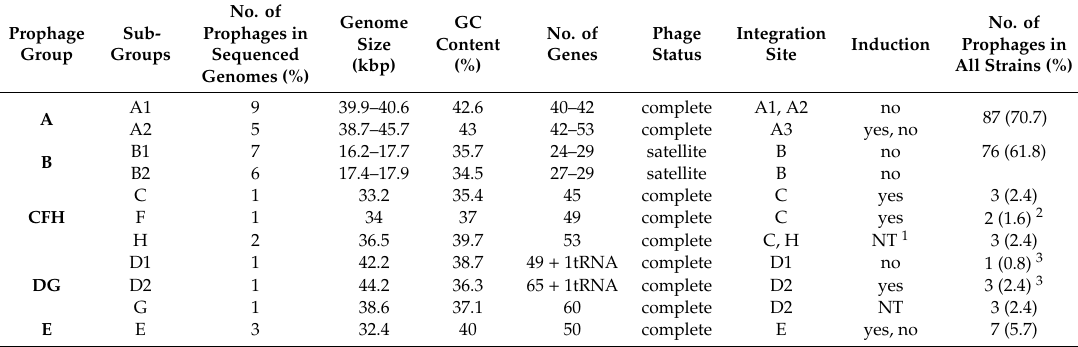
1 Not tested; 2 presence of prophage F-specific gene fib but not complete prophage was detected in three strains; 3 presence of prophage D marker genes or occupation of prophage D integration site but not complete prophage was detected in six